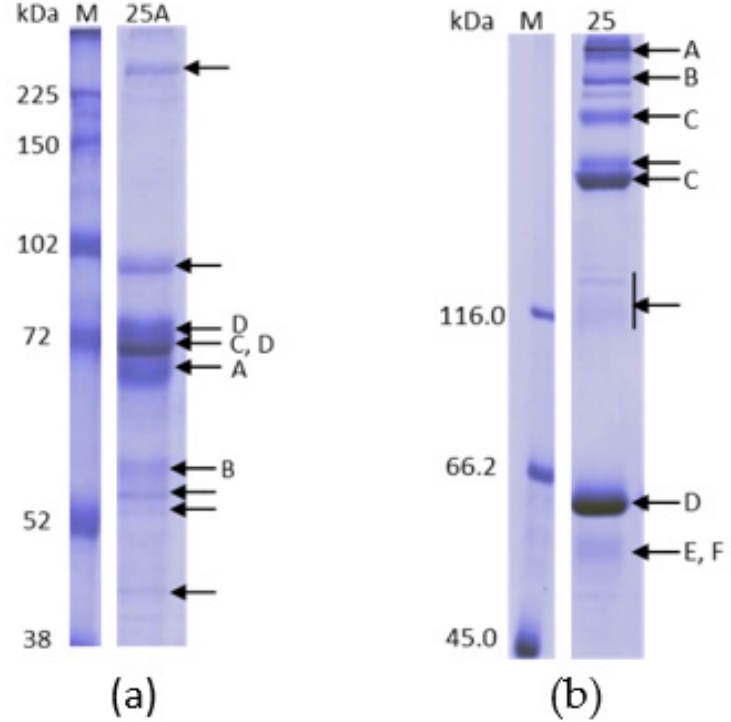
Figure 9. ( a ) SDS-PAGE 7.5% analysis under reducing conditions of fraction 25A of the purification of plasma on ANX Sepharose FF with stepwise 25 mM CaCl 2 gradient. Bands marked with an arrow were analyzed by mass spectrometry. The identified were: [A] Complement C4b Binding Protein (C4bBP); [B] Fibrinogen; [C] Complement C4; and [D] Prothrombin (FII); and ( b ) SDS- PAGE 6% analysis under non-reducing conditions of fraction 25 of purification of plasma on ANX Sepharose FF with stepwise 10 mM and 25 mM CaCl 2 gradient. Bands marked with an arrow were analyzed by mass spectrometry. The identified were: [A] Complement C4b Binding Protein (C4bBP); [B] Fibrinogen; [C] Complement C4; [D] Prothrombin (FII); [E] Factor IX (FIX); and [F] Protein Z. Table 3. Proteins identified by mass spectrometry of the fraction “25A” from plasma purification on ANX Sepharose FF using stepwise 25 mM CaCl 2 gradient.